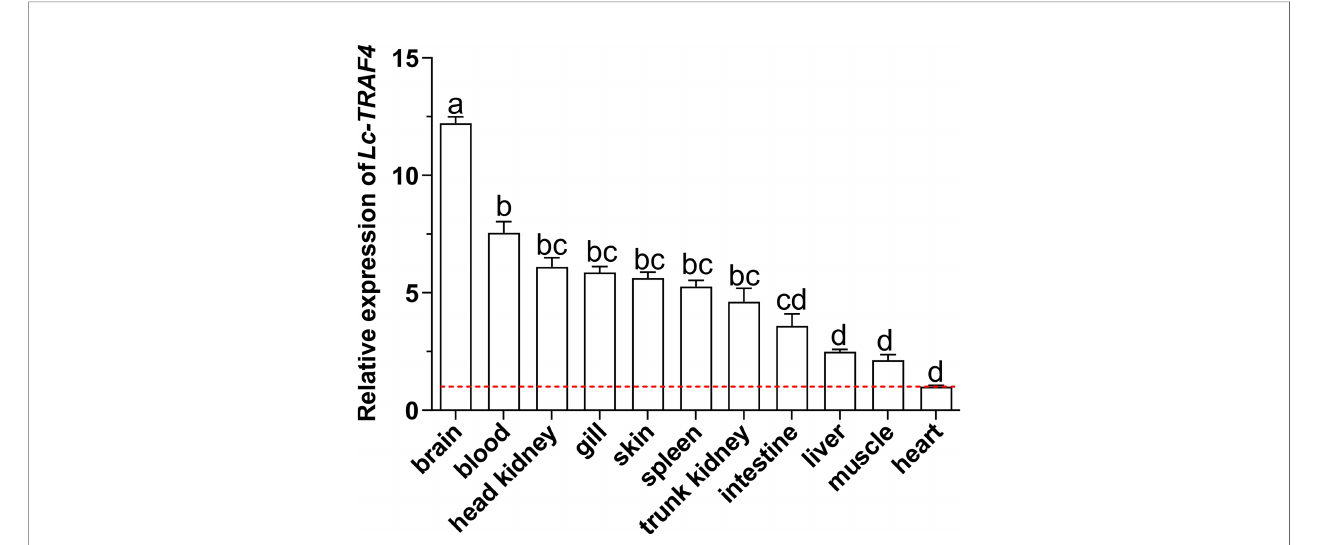
TRAF4, including TRAF4- D RING, TRAF4- D RING/zinc 1, and TRAF4- D MATH were signi fi cantly lower compared to the full- length form of TRAF4 ( Figures 5E – G ). It is thus suggested that the RING fi nger and zinc fi nger domains of Lc -TRAF4 may function in the activation of IRF3, IRF7, and IFN1 signaling.